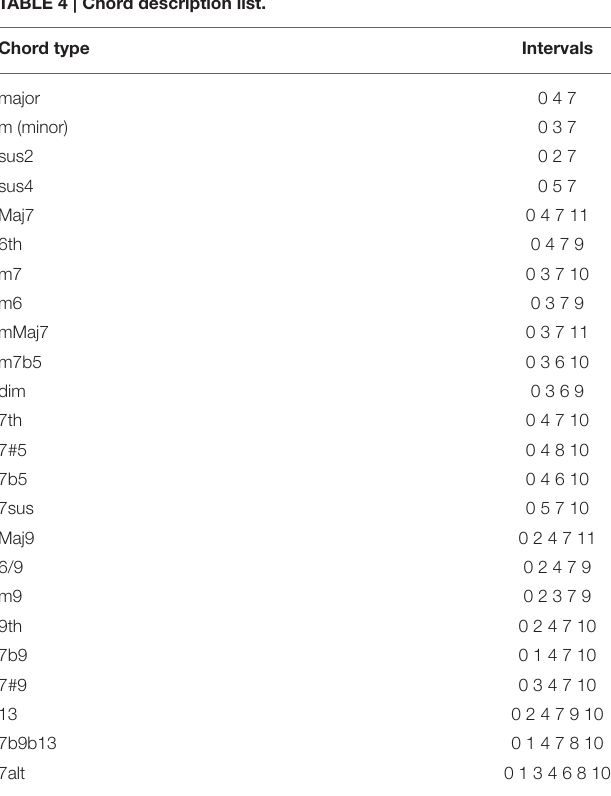
TABLE 4 | Chord description list.